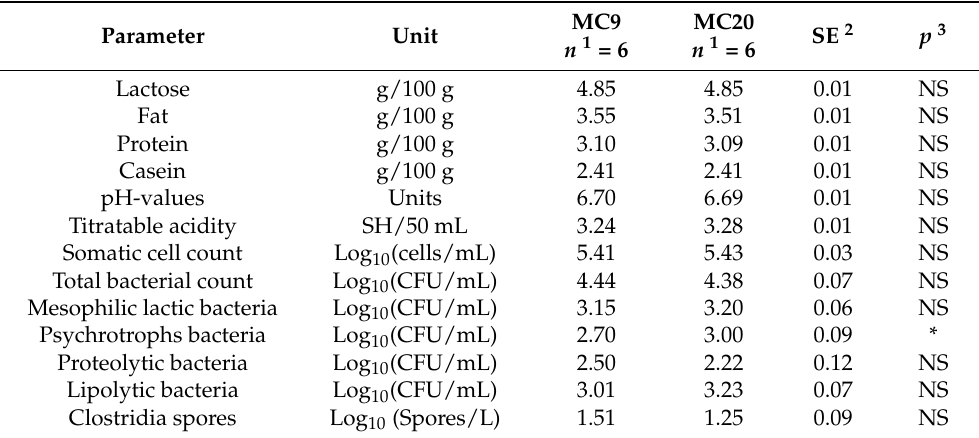
Table 1. Chemical composition and microbiological characteristics of the full cream evening milk kept at the herd at 9 ◦ C (MC9) or 20 ◦ C (MC20) (least-square-mean values). Parameter